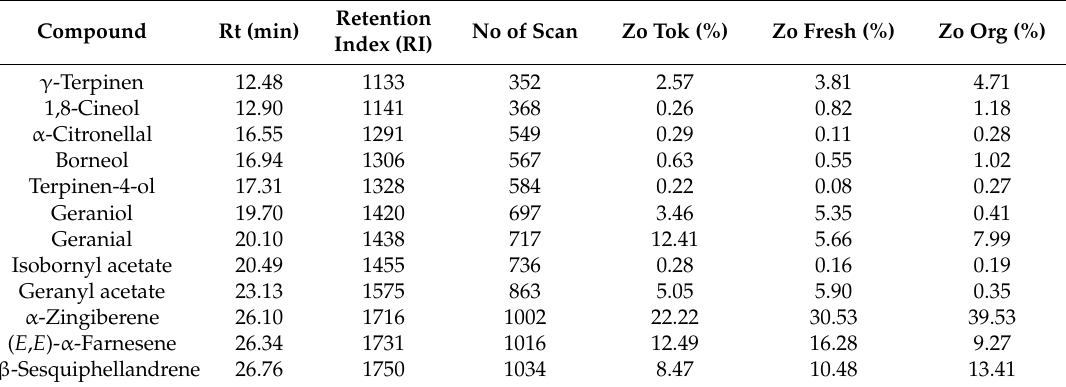
Table 1. The GC ‐ MS identification data on volatile components present in three collective fractions from column 1 and their content in three studied total extracts.